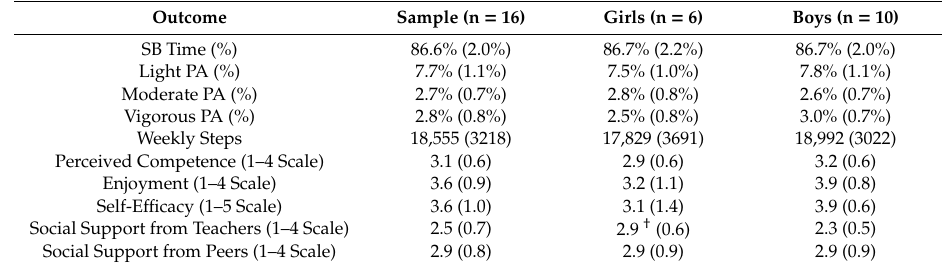
Table 1. Descriptive statistics for the total sample and within sex groups at baseline (week 1; means and standard deviations).